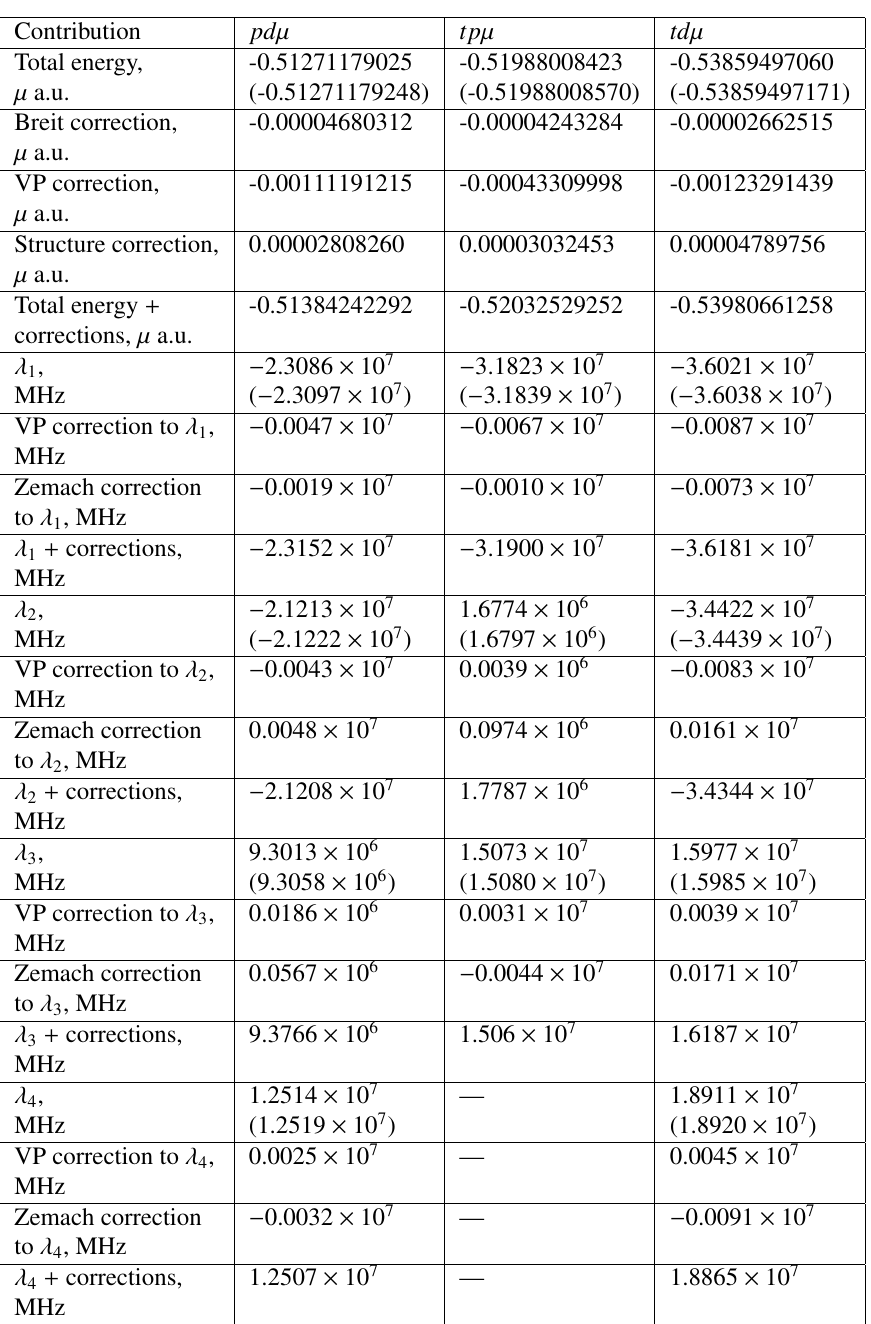
Table 1. Numerical results for hydrogen mesomolecular ions. Numerical values for ground state and hyperfine structure as well as QED corrections are presented. In parenthesis numerical results from [3] are